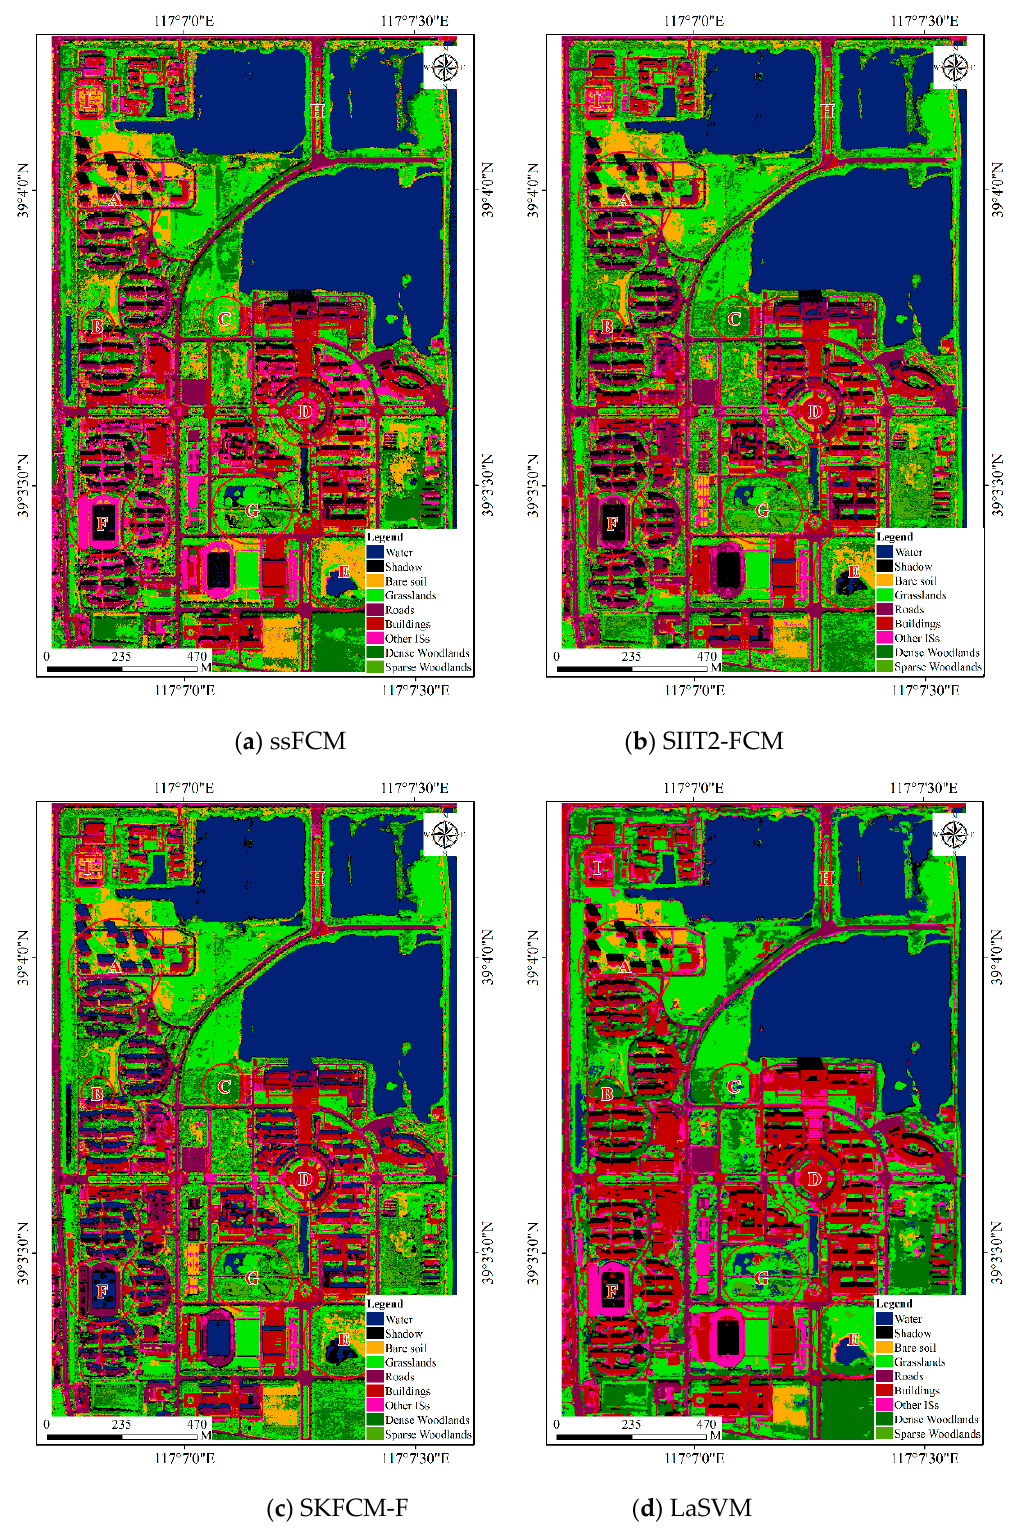
Figure 11. The results of ssFCM, SIIT2-FCM, SKFCM-F and LaSVM respectively.